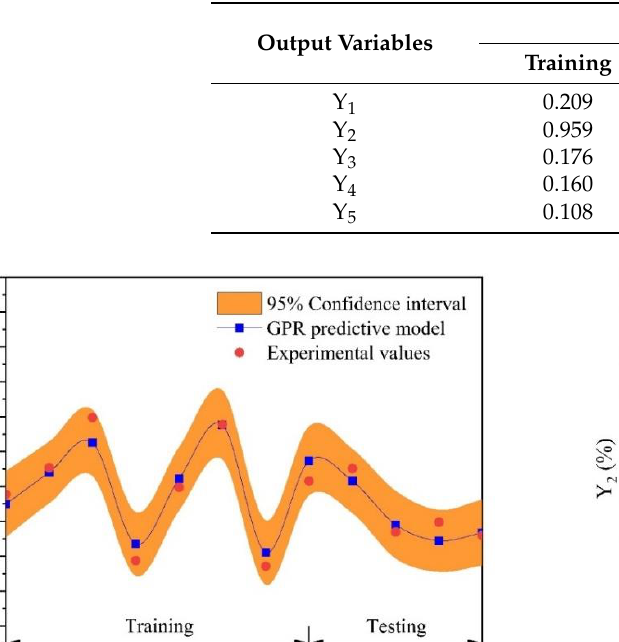
Table 9. RMSE and R 2 for volumetric and physical properties of asphalt mixture.